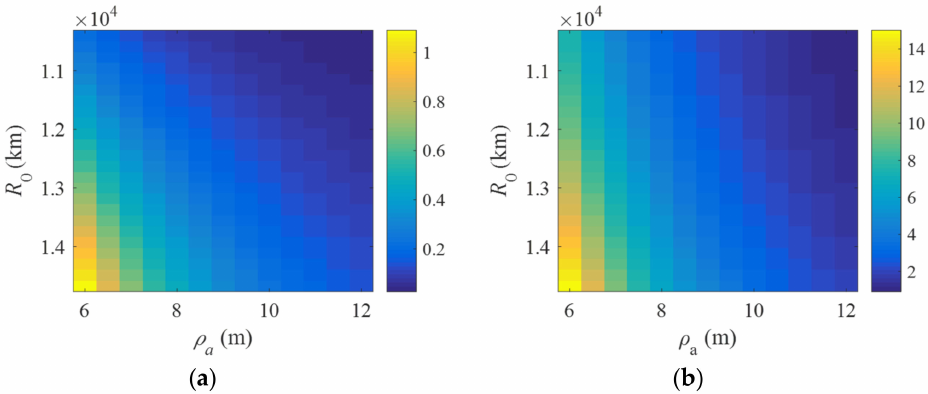
Figure 6. Dependency between the phase error and ρ a and R 0 for the C band system. ( a ) Targets with constant speeds and ( b ) accelerating targets. In the figures, the color indicates the value of the phase error, and the unit is